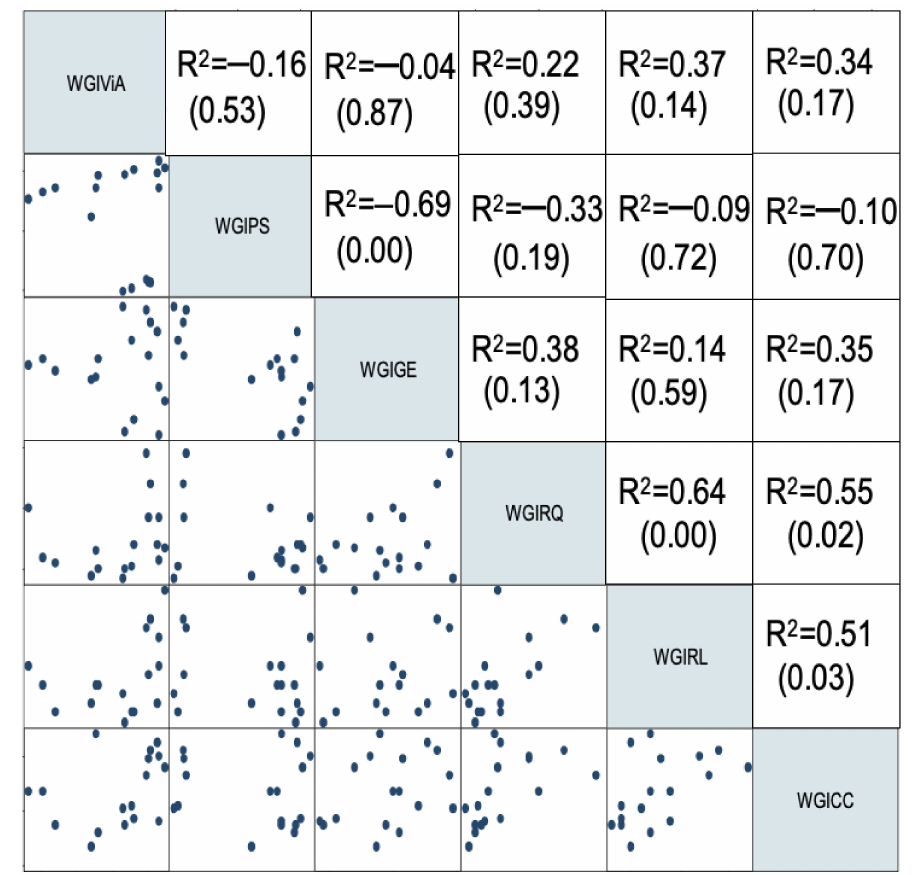
Figure 2. A correlation matrix of WGI for Ukraine, 2002–2019 (Source: developed by the authors). WGIVIA—political and civil liberties; WGIPS—government political stability; WGIGE—freedoms and qualifications of public authorities; WGIRL—public confidence in government action; WGICC—